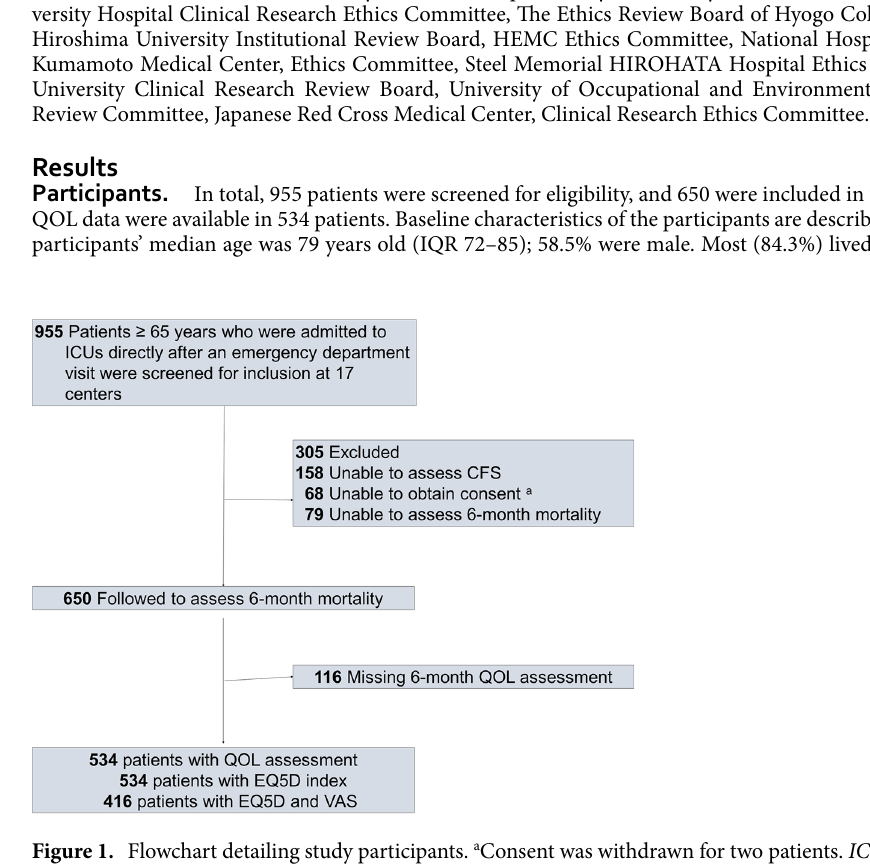
Figure 1. Flowchart detailing study participants. a Consent was withdrawn for two patients. ICU intensive